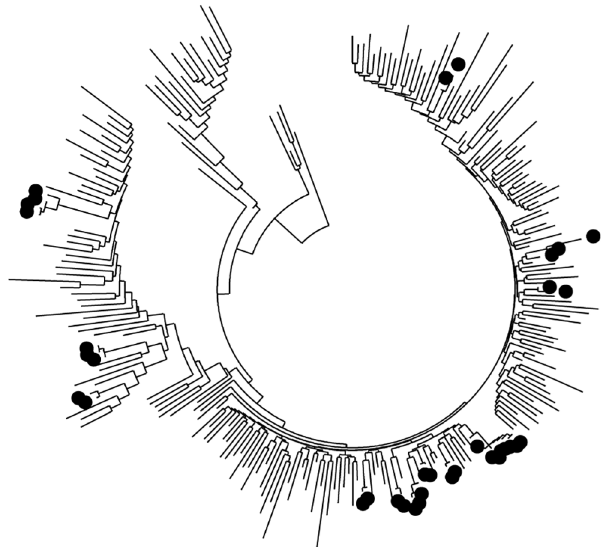
Fig 2. HIV-1 transmission clusters among heterosexuals in the Gem and Asembo region of Western Kenya. Phylogenetic tree showing HIV-1 transmission clusters in the Gem and Asembo region. The highlighted tree nodes represent members in transmission clusters with bootstrap values of 85% and mean genetic distance of 0.015-nucleotide substitution per site. Sequences with drug resistance mutation are highlighted with grey. The clusters correlate with the demographic information shown in table 4 in a clockwise phase (Cluster 1 through 12).